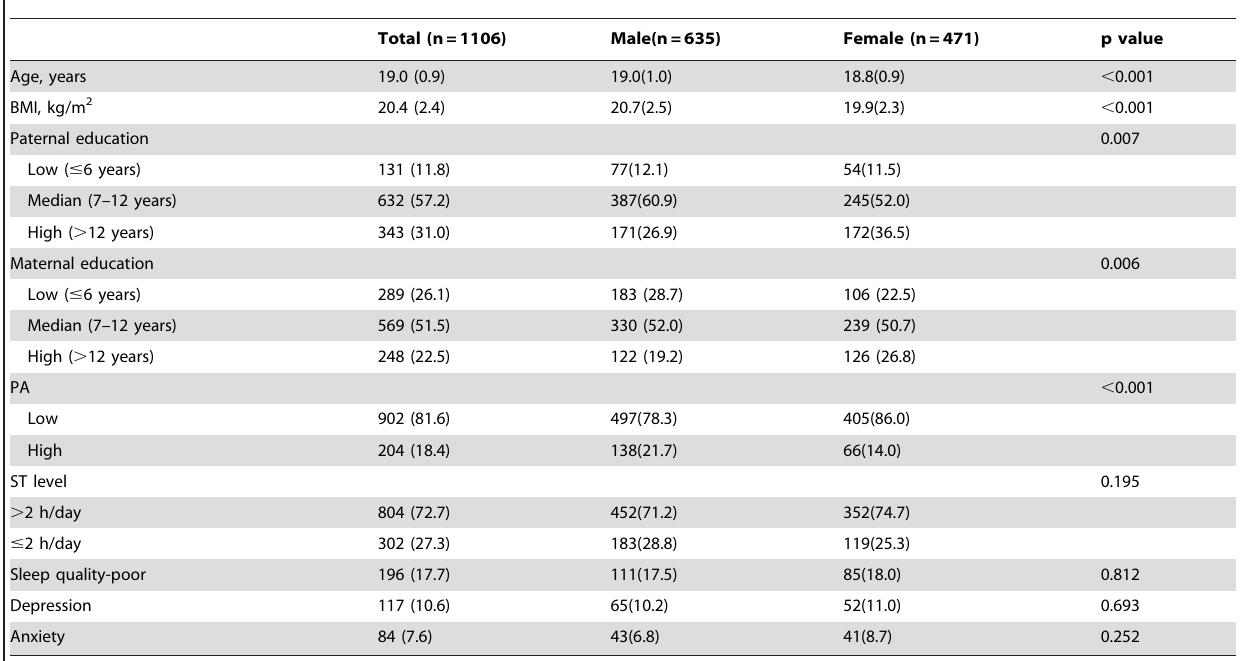
Table 1. Basic characteristics of the study subjects.